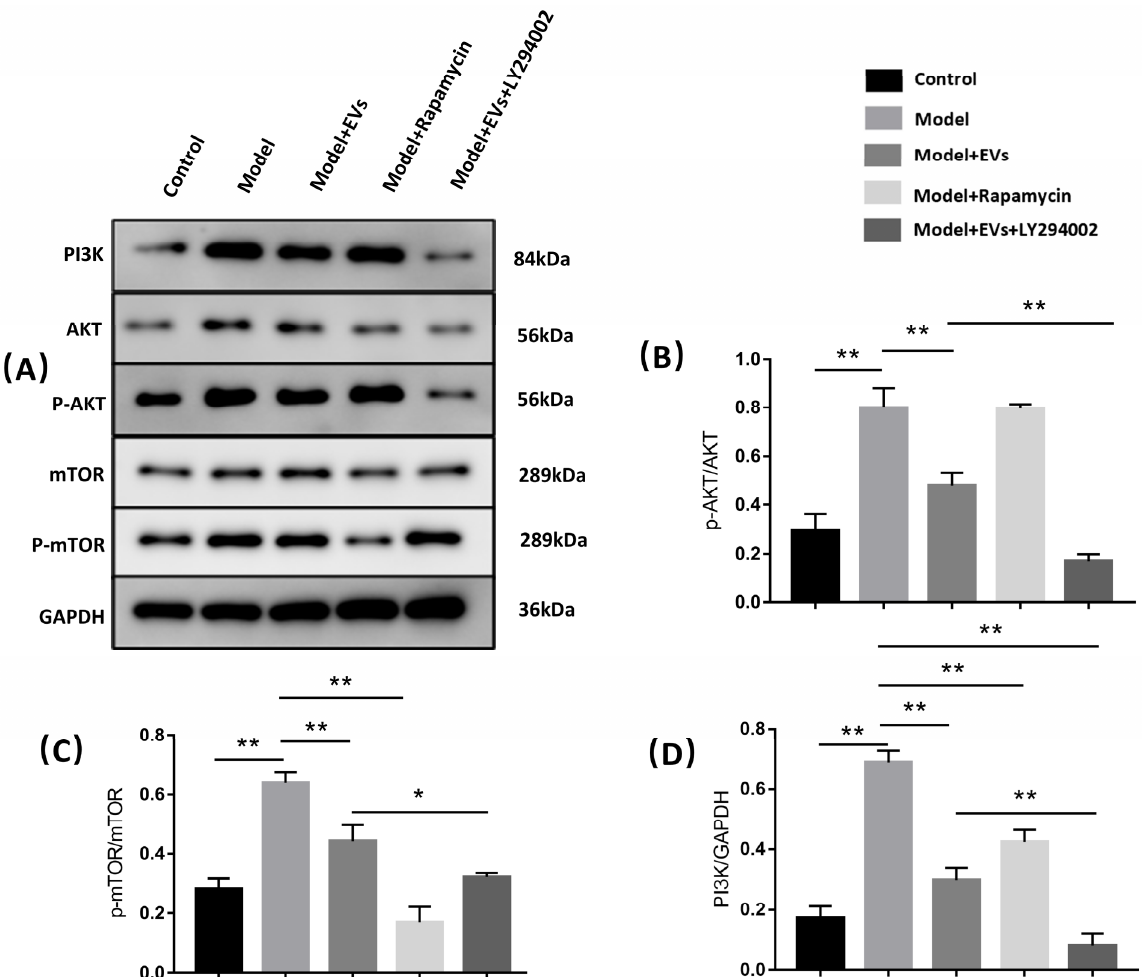
Figure 7. BMSC-EVs regulated the level of BMECs autophagy via PI3K/Akt/mTOR pathway. ( A ) Western blot analysis. ( B – D ) Quantification of p-Akt, Akt, p-mTOR, mTOR and PI3K in five groups. Each bar represents the mean ± SD of three independent experiments. * p < 0.05, ** p < 0.01. EVs, BMSC-derived extracellular vesicles; GAPDH, glyceraldehyde 3-phosphate dehydrogenase; mTOR, mammalian target of rapamycin.